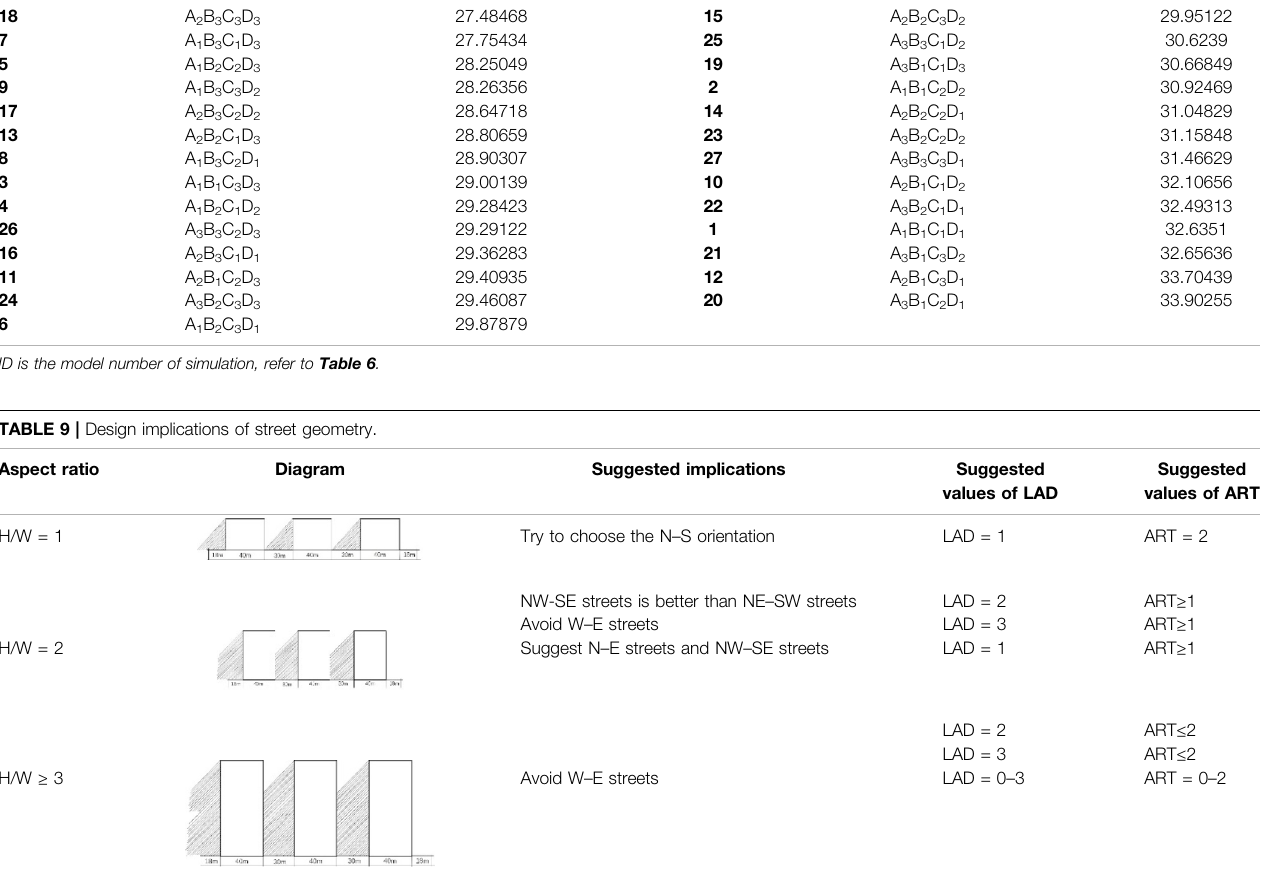
TABLE 8 | Ranking average PET of 27 models from low to high.